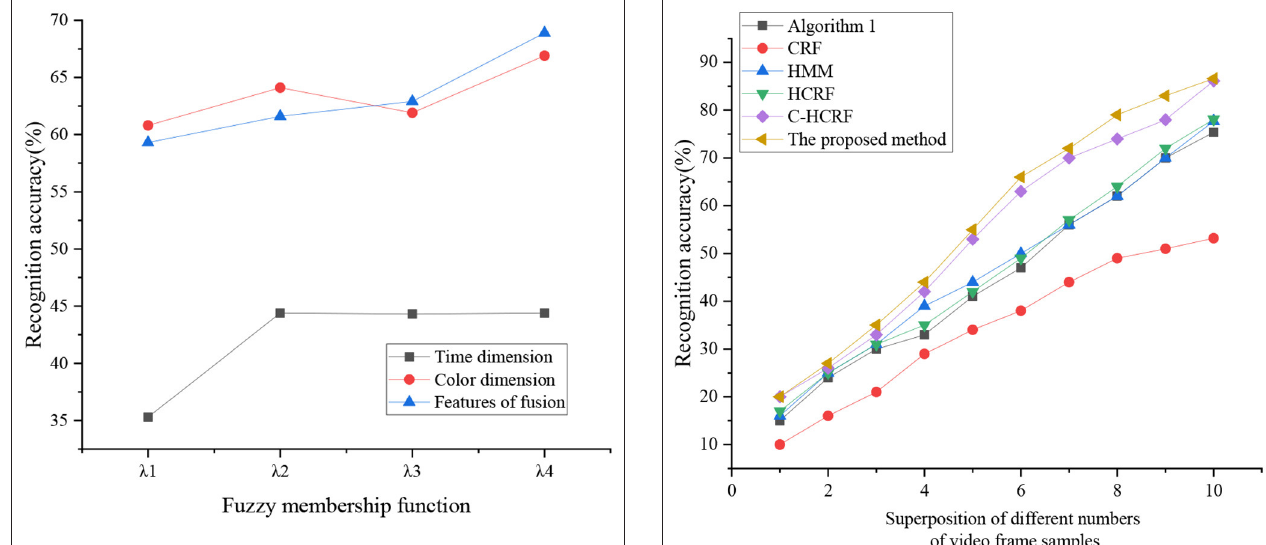
FIGURE 11 | Comparison of micromotion processing capabilities of different algorithms. FIGURE 12 | Comparison of accuracy of micromotion recognition with